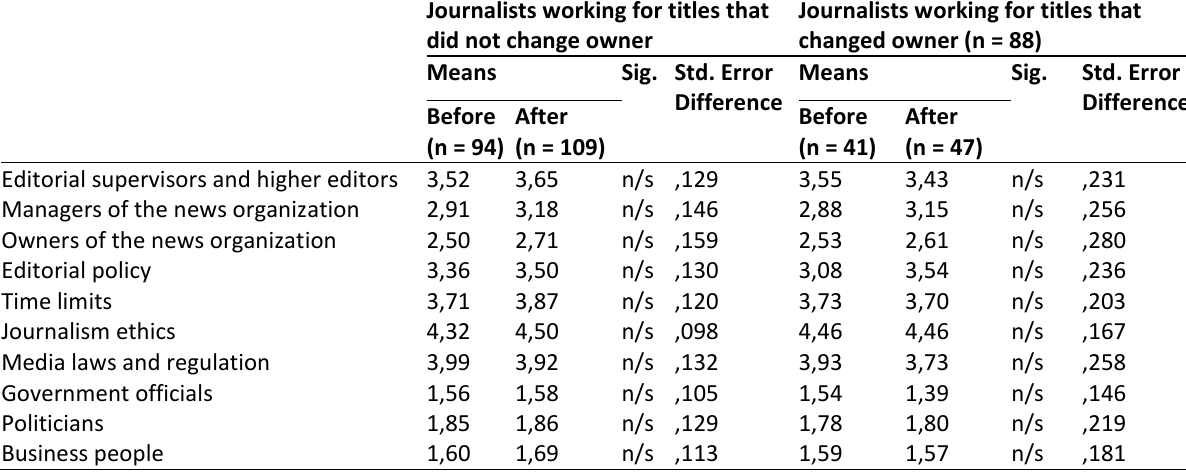
Table 4. Perception of influences on journalism before and after the media takeover in 2013 (means, independent samples t-test).